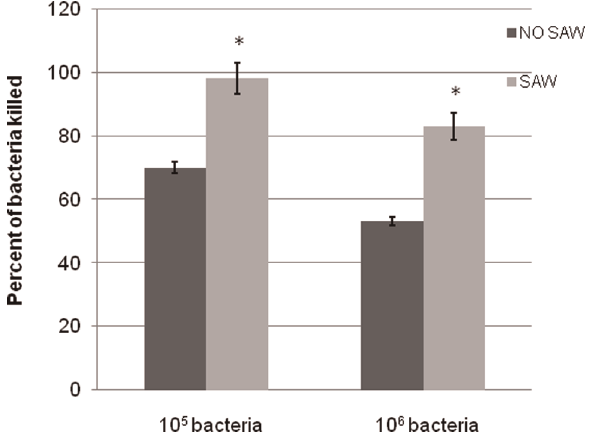
Figure 2. Killing of S. epidermidis bacteria in fibrin gels. S. epidermidis killing by 4 6 10 6 /mL human neutrophils was measured as described under Materials and Methods. The bacteria were opsonized with 10% human serum for 30 mins before incubating them with the neutrophils and the killing of the bacteria by the neutrophils was assessed after a 90 mins incubation period as described under Materials and Methods. Values are the percent killing 6 SEM (n=4). The difference between control and SAW treated cells are statistically significant at the p , 0.001 level.